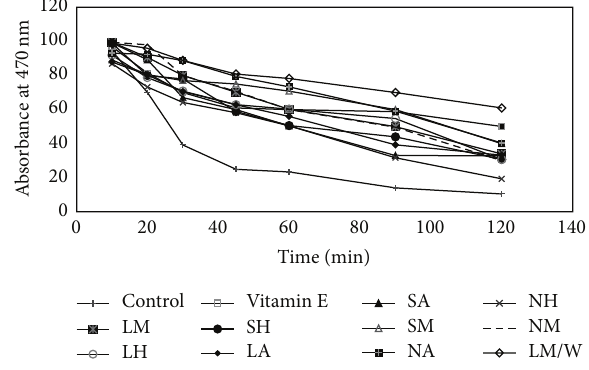
Figure 4: 𝛽 carotene bleaching assay of chetoui O. europaea variety nuts, stem and leaves